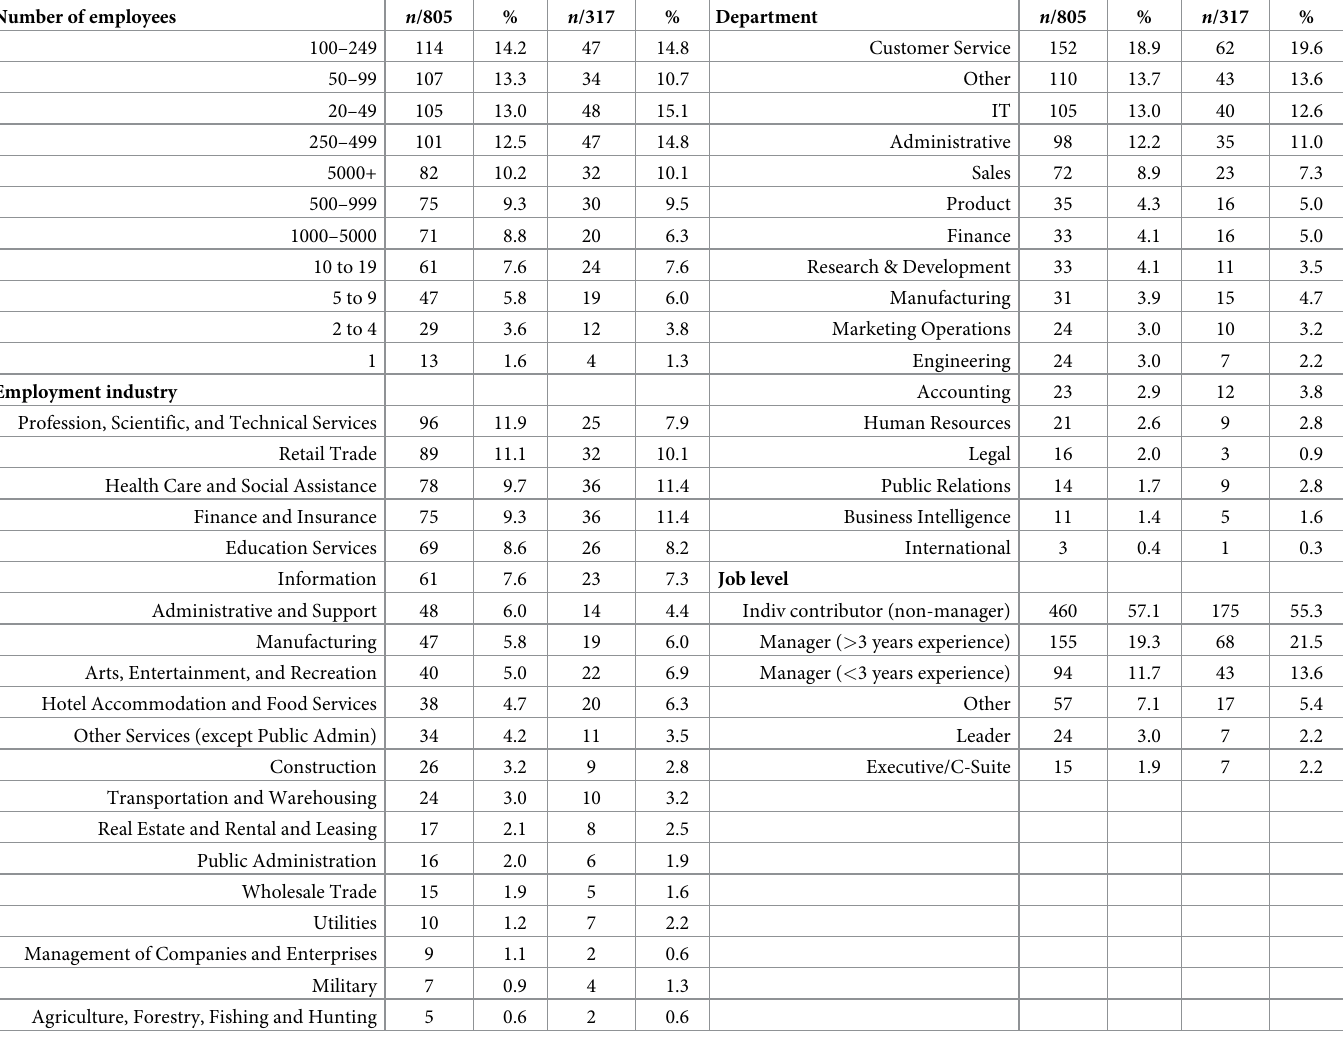
Table 2. Employment information for full sample ( N = 805) and subset of sample ( n = 317) used in analyses. Number of